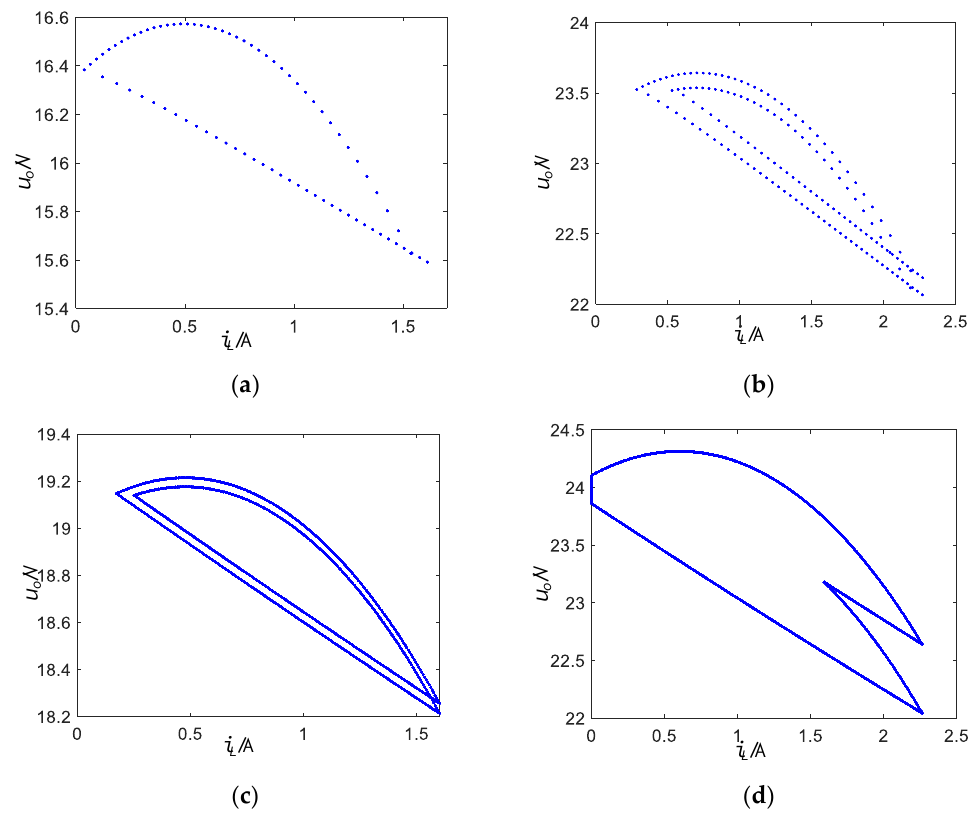
Figure 9. The V-I phase portrait of the different values of the reference current: ( a ) I ref = 1.6 A, α = β = 0.85; ( b ) I ref = 2.26 A, α = β = 0.85; ( c ) I ref = 1.6 A, α = β = 1; and ( d ) I ref = 2.26 A, α = β = 1.